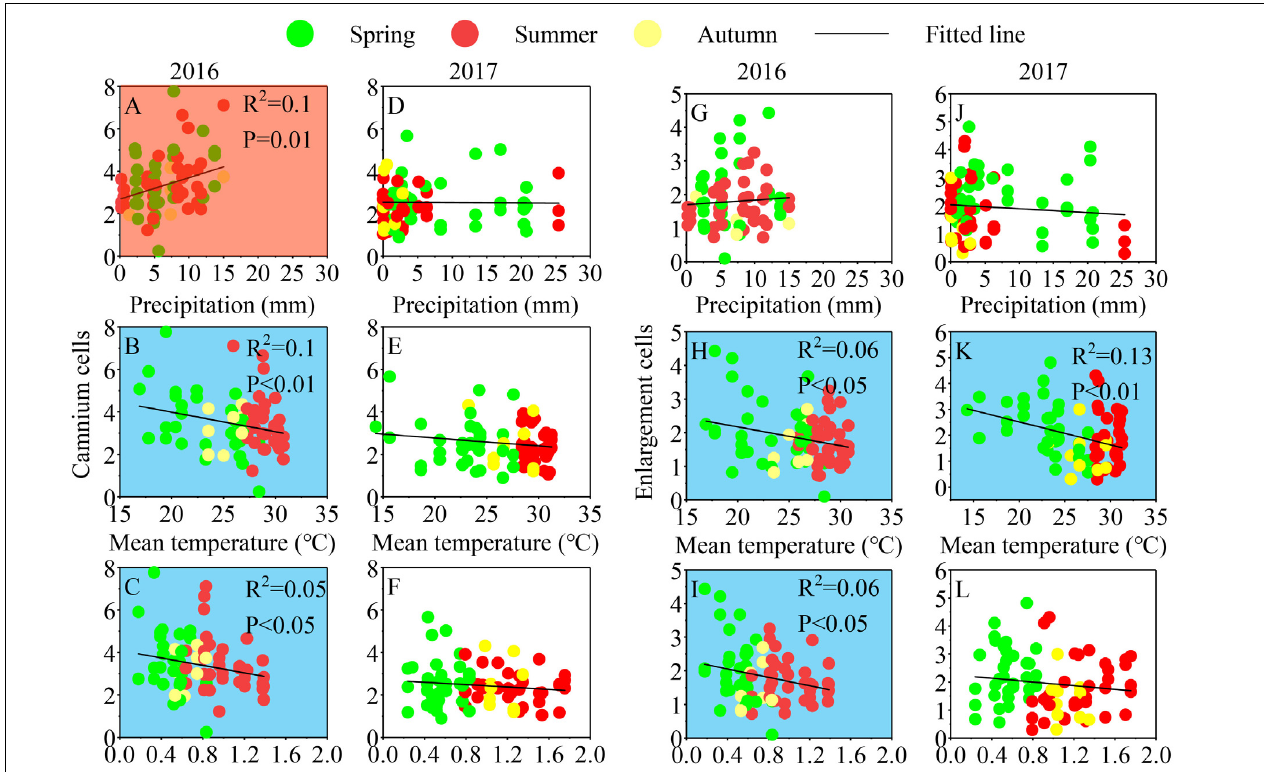
FIGURE 5 | Relationships between climate variables and the number of cells in cambium (A–F) and enlargement (G–L) of Cryptomeria fortunei during 2016–2017. Significant correlations ( p < 0.05) were shaded red (positive) and blue (negative).